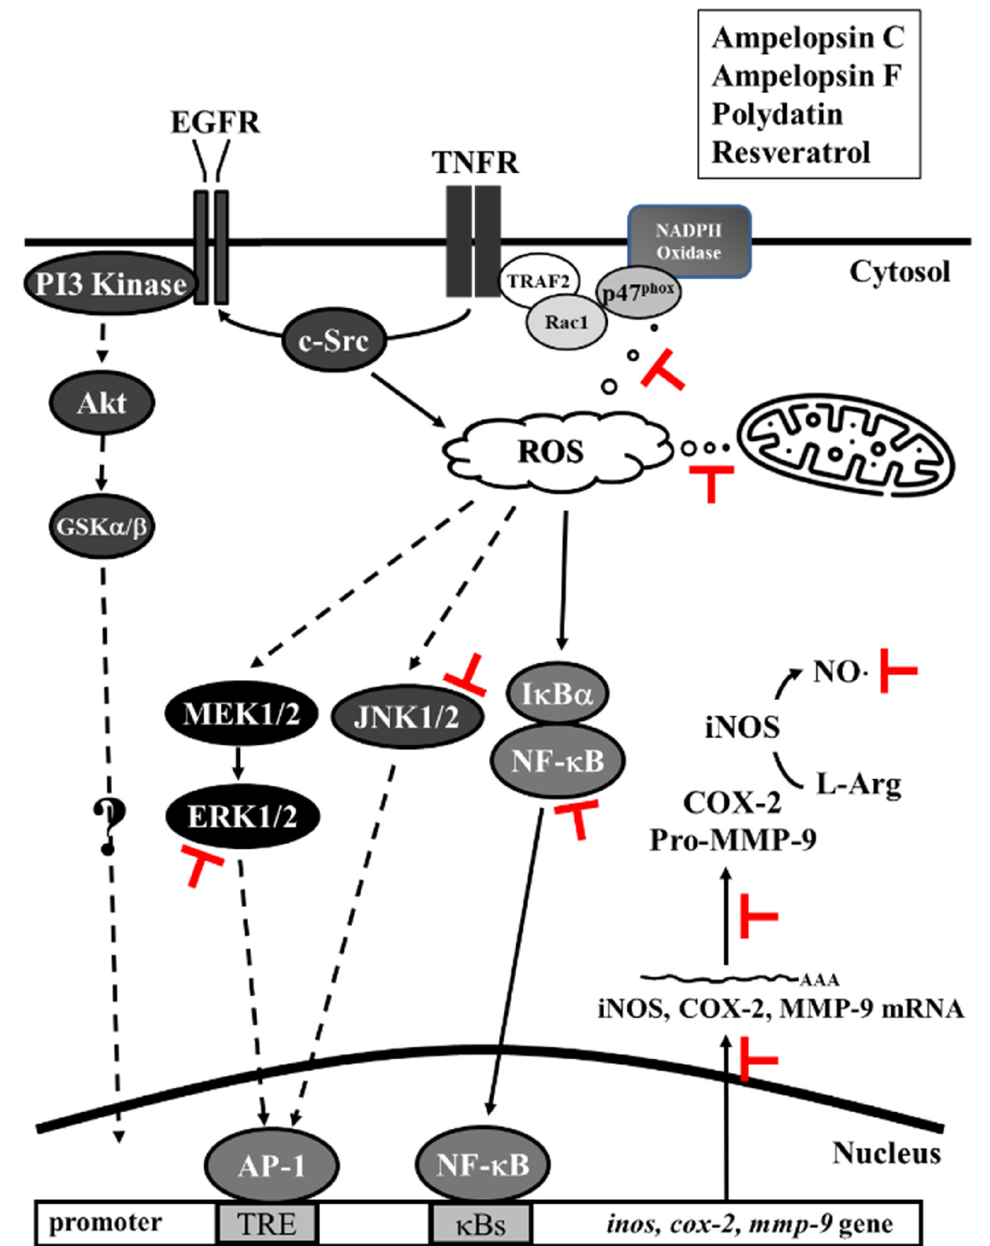
Figure 9. Pharmacological diagram of the inhibition of TNF- α -induced inflammatory proteins by Res derivatives. The TNF- α -induced activation of MAPKs and NF- κ B was mediated by ROS derived from mitochondria and NADPH oxidase. TNF- α binding to TNFR recruited Rac1 and p47 phox , thus activating NAPDH oxidase. In addition, the expression of MMP-9 induced by TNF- α was mediated by the MAPK, EGFR, and classical NF- κ B pathways, respectively. However, Res derivatives inhibited the ROS derived from mitochondria and NADPH oxidase, the RNS derived from iNOS, the activation of ERK1/2 and JNK1/2, and NF- κ B, which were induced by TNF- α